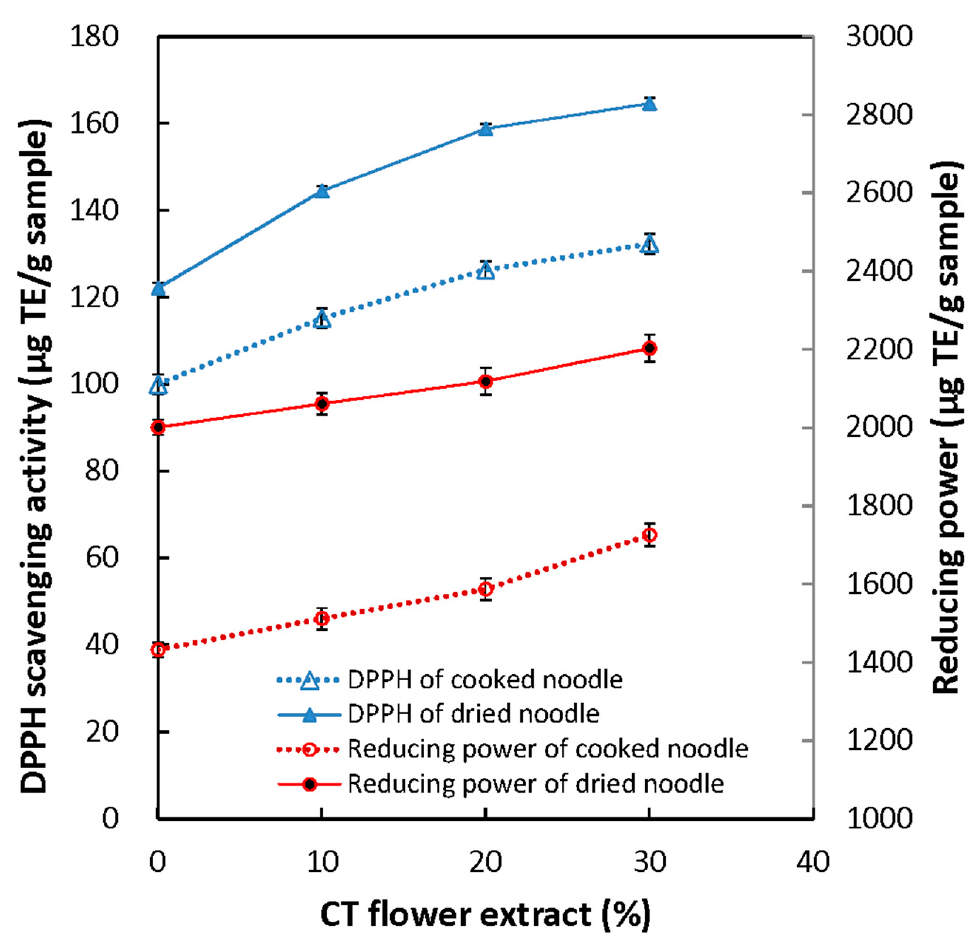
Figure 2. DPPH scavenging capacity and reducing power of both dried and cooked noodles fortified with various CTFE amounts.